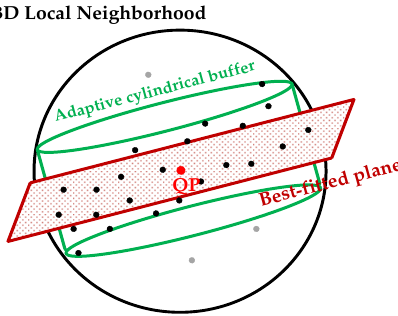
Figure 3. Established adaptive cylindrical buffer for local point density estimation in a planar neighborhood.